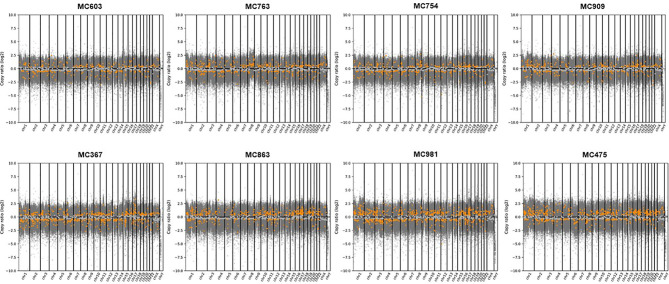
Copy number alterations analyzed by CNVkit in eight representative cases of PMBCs subjected to WES. Copy numbers of genes in each PMBC were plotted segmented log2 ratios (y-axis) according to their genomic positions (x-axis). Gray spots indicate mean copy number and orange spots mean gain or loss of genes.